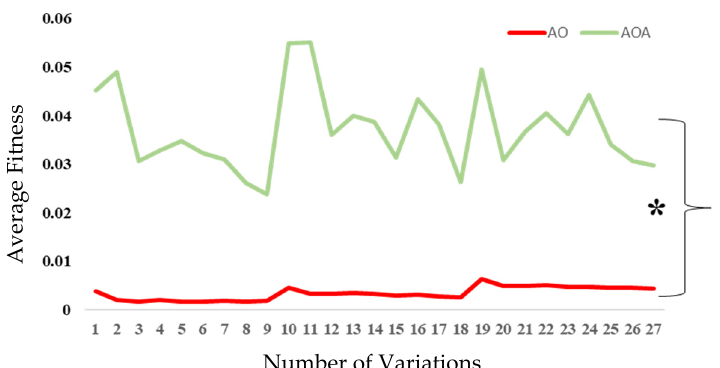
Figure 8. Mann-Whitney U test between AO and AOA where * p < 0.01.